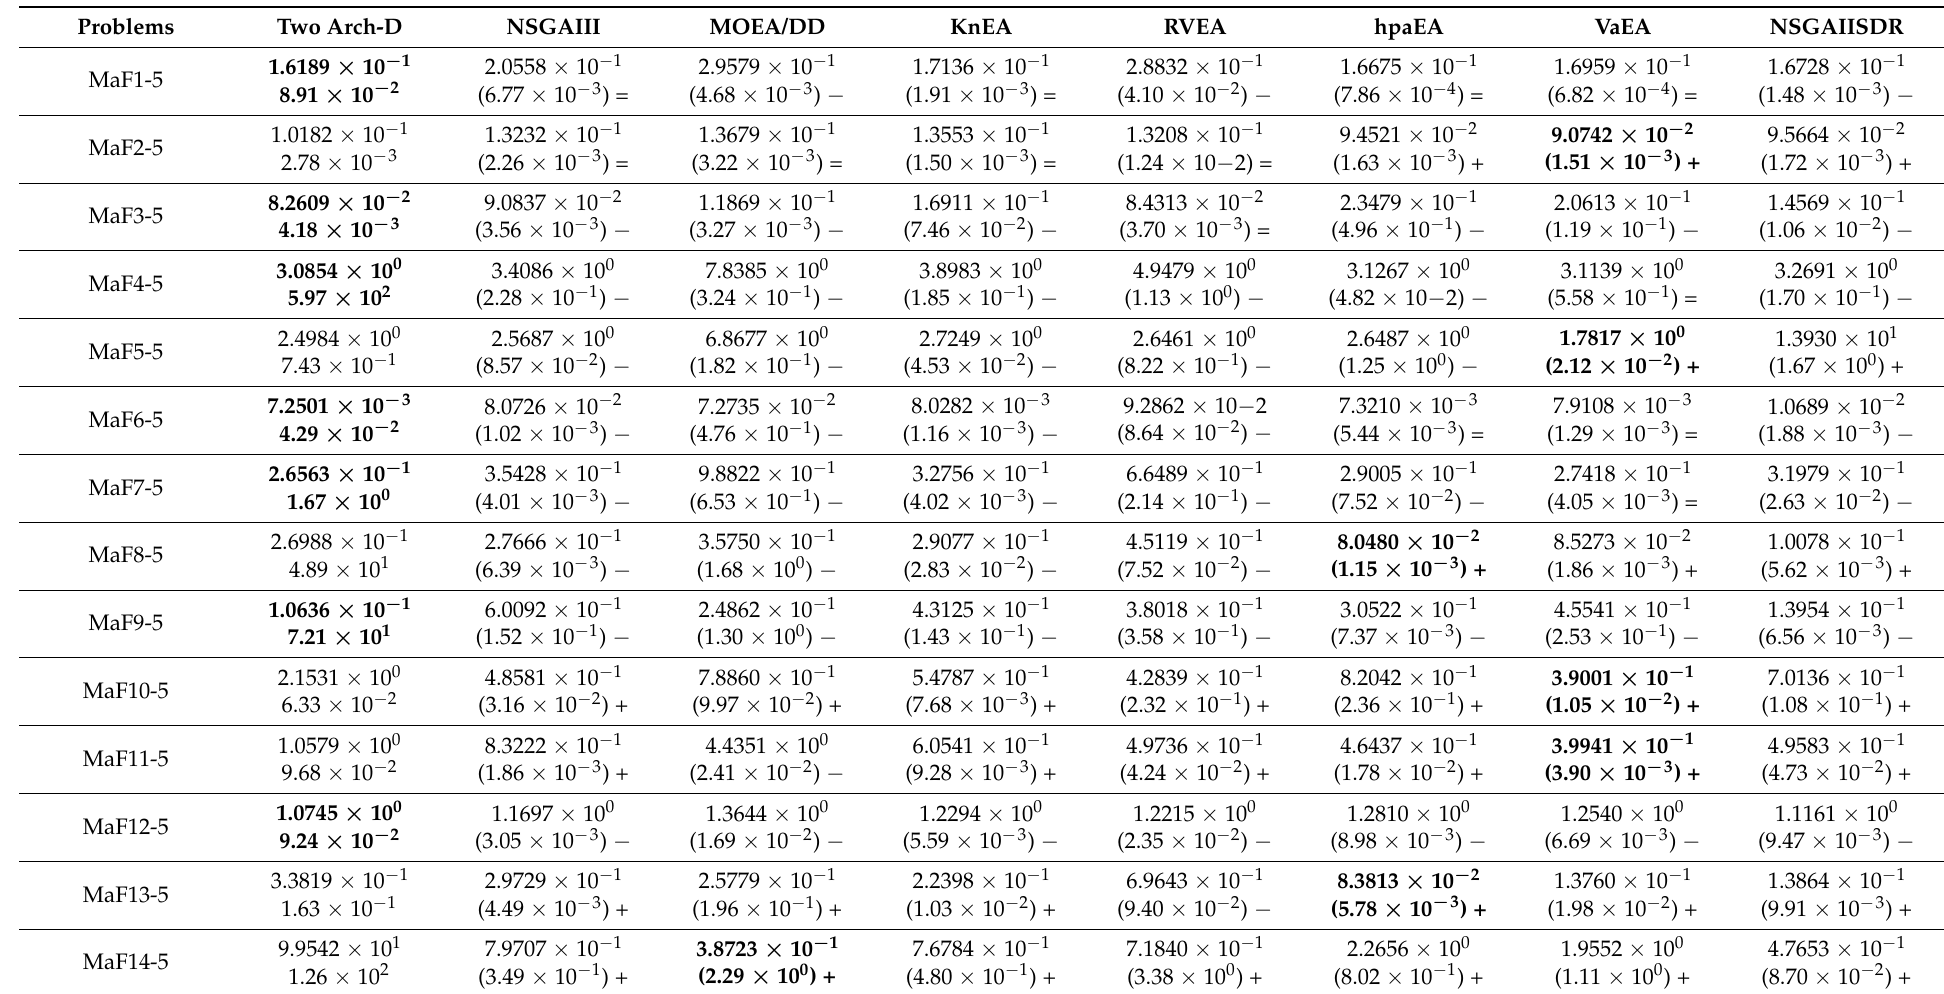
Table 1. IGD mean and standard deviation values of each